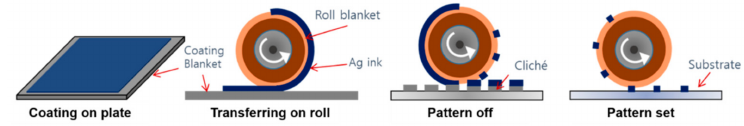
Figure 3. The schematic explanation of reverse offset printing process.